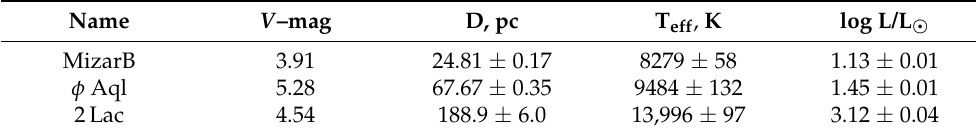
Table 4. Fundamental parameters of the studied systems.